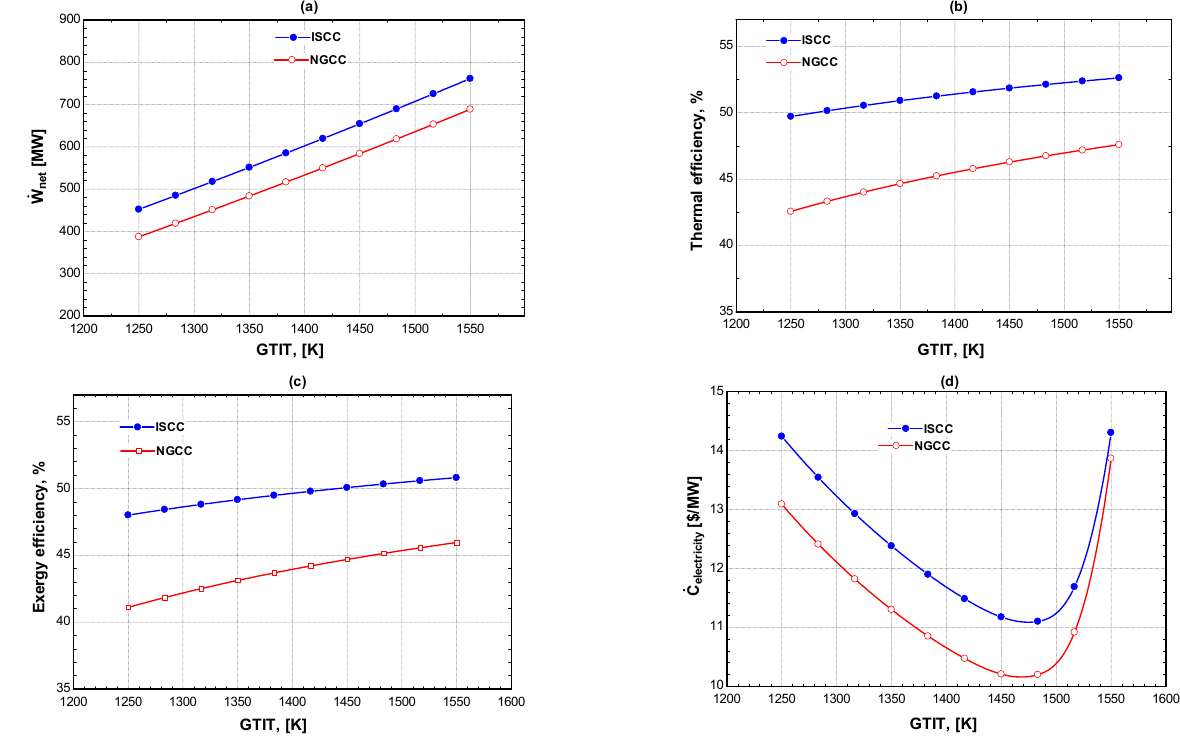
Figure 4. The effect of GTIT on the overall performance and cost of both systems: ( a ) the total produced power, ( b ) thermal efficiency, ( c ) exergy efficiency, and ( d ) total rate of production costs.